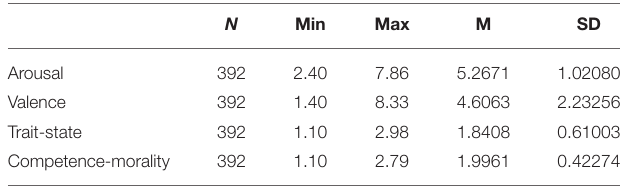
TABLE 1 | Descriptive statistics calculated for each dimension for all the intelligible